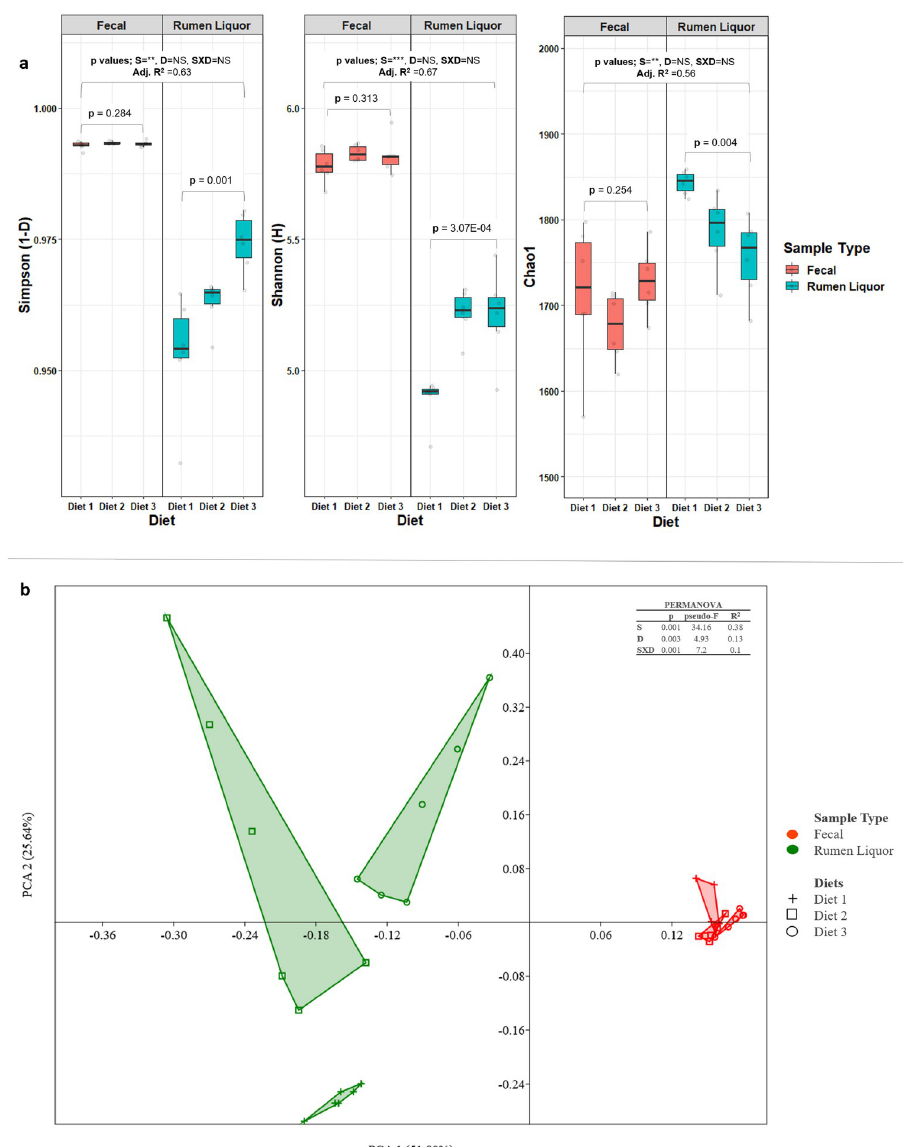
Fig 2. Alpha and beta diversity analysis. a . Box-and-whiskers plot for estimated alpha diversity indices in the fecal and rumen liquor microbiota. NS = Not Significant, � = Significant at p = 0.05, �� = Significant at p = 0.01, ��� = Significant at p = 0.001. b . principal coordinate analysis (PCOA) of fecal and rumen liquor microbial communities. The axis of principal component 1 (PC1) described 51.8% and principal component 2 (PC2) described 25.64% of total data variability. PCOA was performed using PAST v3.13 [35]. S = sample type, D = diet and SXD = sample type X diet